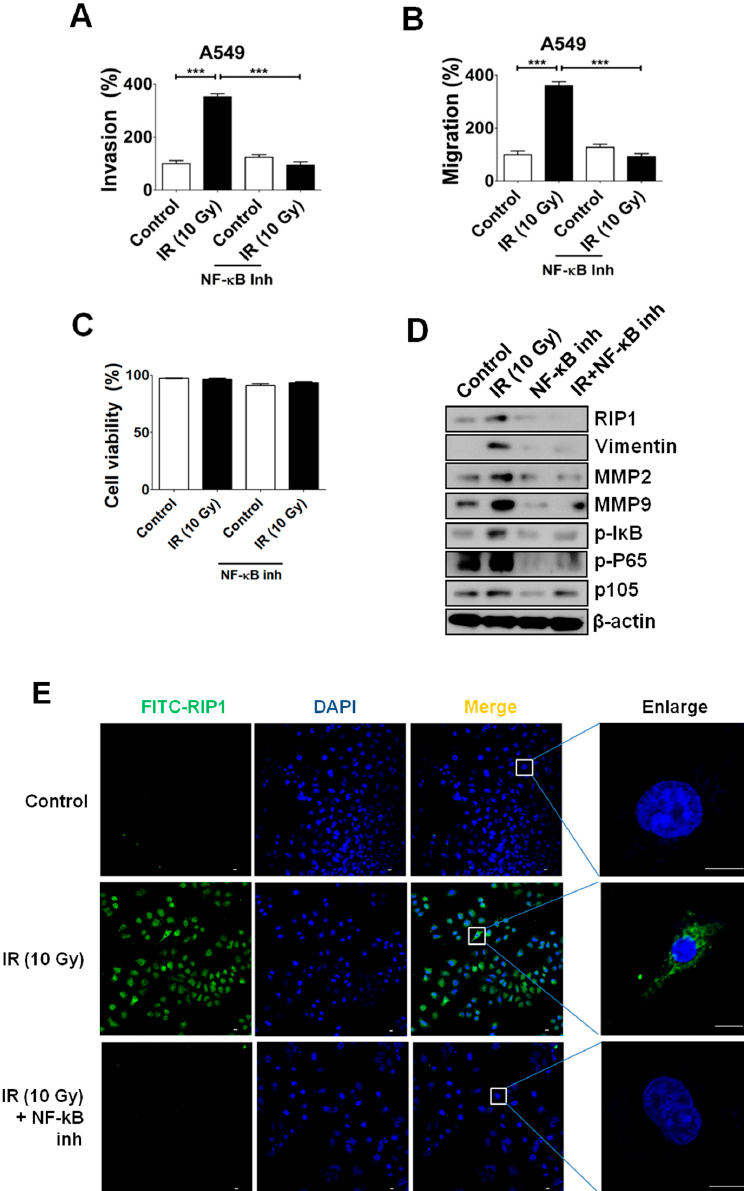
Figure 6. Expression of RIP1 and EMT progression is induced by NF- κ B following IR exposure. ( A ) To examine the mechanisms underlying IR-induced invasion of A549 cells, necrostatin was added to the lower chamber of a transwell system and cells were seeded onto the upper chamber. After 24 h, cells on the membrane were counted. (***; p < 0.001) ( B ) IR-induced migration of A549 cells. Experiments were performed as described in Materials and Methods. Representative data from triplicate experiments are shown on the right panel. (***; p < 0.001) ( C ) Cells were subjected to IR (10 Gy) and treated with BAY 11-7082 (NF- κ B inhibitor), and apoptotic death was determined using the PI uptake assay. Representative data from triplicate experiments are shown. ( D ) A549 cells were subjected to IR (10 Gy) and treated with BAY 11-7082 (NF- κ B inhibitor, 10 nM). Expression levels of RIP1, MMP-2, MMP-9, I κ B- α p-P65, p105, vimentin and β -actin (loading control) were determined via immunoblotting. Representative data from triplicate experiments are shown. ( E ) Immunofluorescence staining of RIP1-positive A549 cells following exposure to IR. Endogenous RIP1 expression in IR-treated and non-treated A549 cells was determined. A549 cells were stained with DAPI to visualize nuclei (blue) and immunolabeled with an anti-RIP1 antibody, which was detected with FITC-conjugated IgG (green). Scale bar: 10 µ